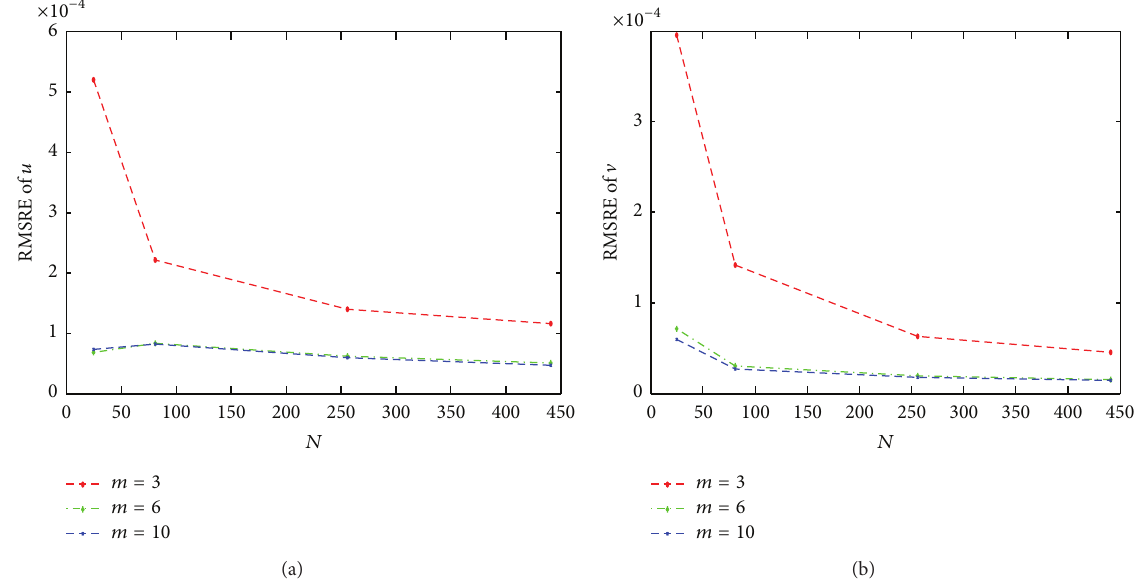
Figure 2: Both errors of 𝑢 and V against the number of nodal points: 𝑚 = 10 , 𝑡 = 1 , and Δ𝑡 = 0.1 . (a) RMSRE of 𝑢 ; (b) RMSRE of V .